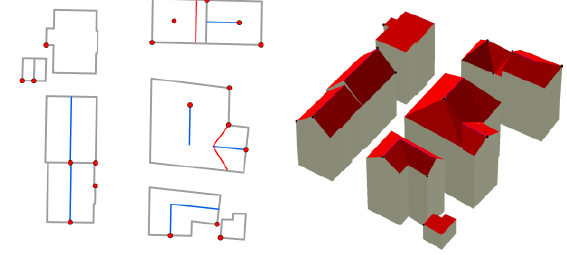
Figure 2. From the building ground plan (left) to the 3D Model (right)